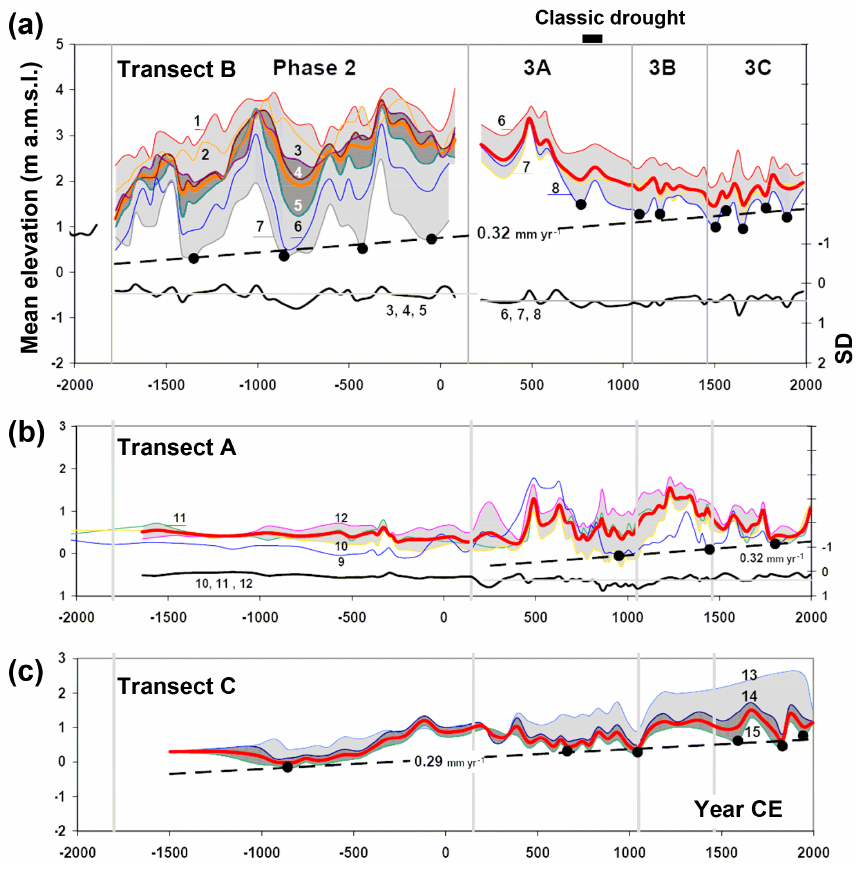
Figure 10. Mean beach-ridge elevation variability along shore-normal Transects B (a) , A (b) , and C (c) . See Fig. 11a for the location of the individual transects. Notice the relatively high beach-ridge elevations around 800–950CE for all three transects. This period is known for the occurrence of multiple prolonged droughts and has been related to the Classic Maya